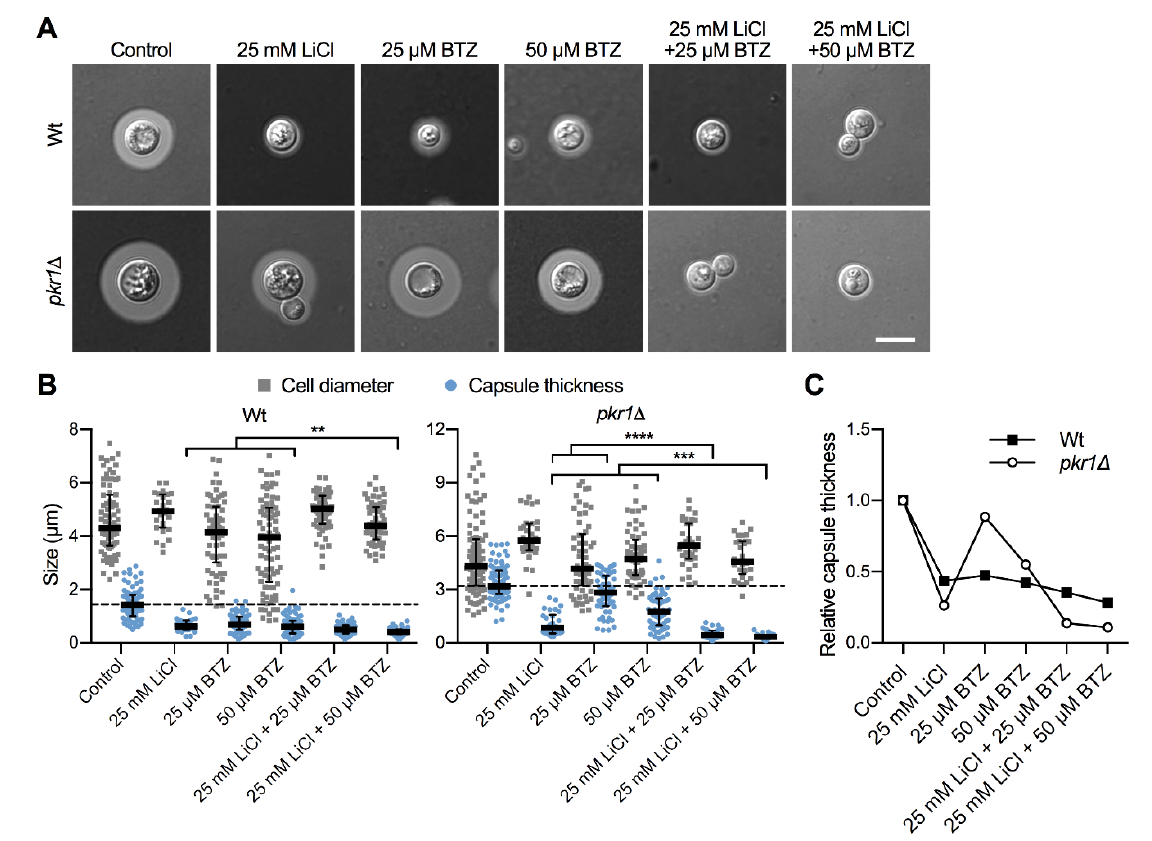
FIGURE 7: Combination of lithium with the proteasome inhibitor bortezomib blocks capsule production. (A) DIC microscopy images of the indicated C. neoformans strains grown in CIM (control) or CIM supplemented with the indicated concentrations of LiCl and/or bortezomib for 48 h and stained with India ink to visualize capsule. Wt, H99S wild type; BTZ, bortezomib. Scale bar, 5 µm. (B) Quantification of cell diameter and capsule thickness for cells from panel A. The experiment was performed twice, and at least 25 cells were analyzed per strain and condition. Small grey squares and blue circles indicate individual data points from both experiments, and the black bar indicates the median – interquar- tile range. The dotted black lines indicate the median capsule sizes of the Wt or pkr1 D mutant grown under control conditions. ** P < 0.01, *** P < 0.001, and **** P < 0.0001 by t -test. (C) Relative capsule thickness data from panel B. Results were plotted relative to the untreated controls. Note that capsule formation by the pkr1 D mutant is less affected by BTZ, but more strongly reduced by LiCl compared to the